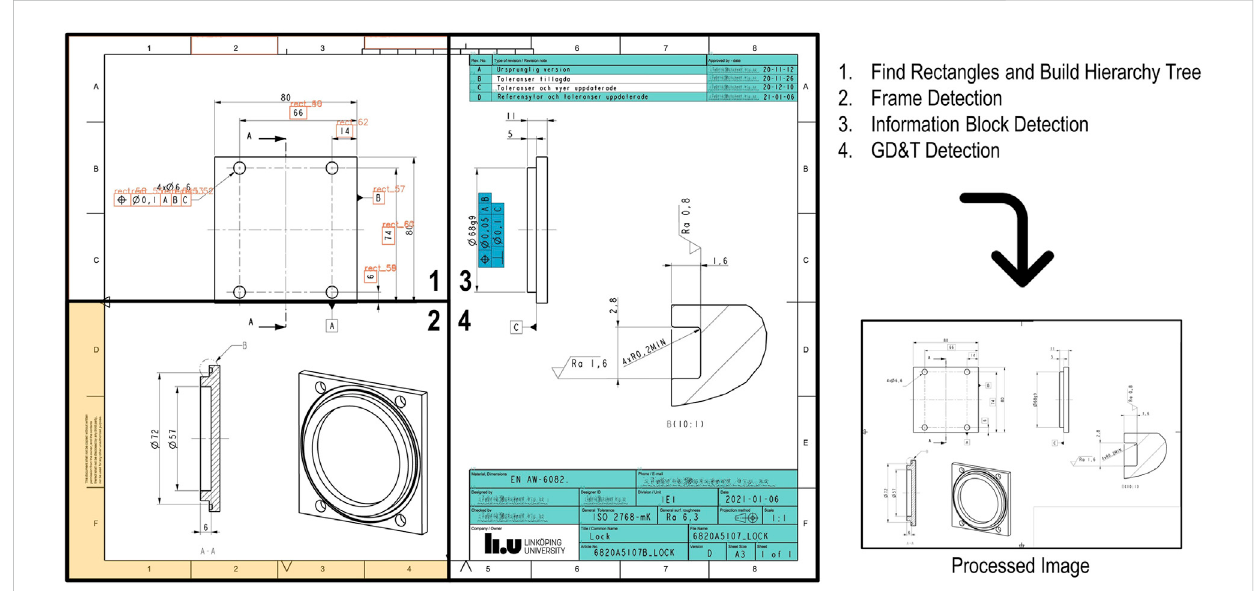
FIGURE 3 ImageProcessingSteps:1)Topleftcorner, fi ndingrectangles.2)Bottomleftcorner,framedetection.3)and4)Rightside,informationblockandFCF